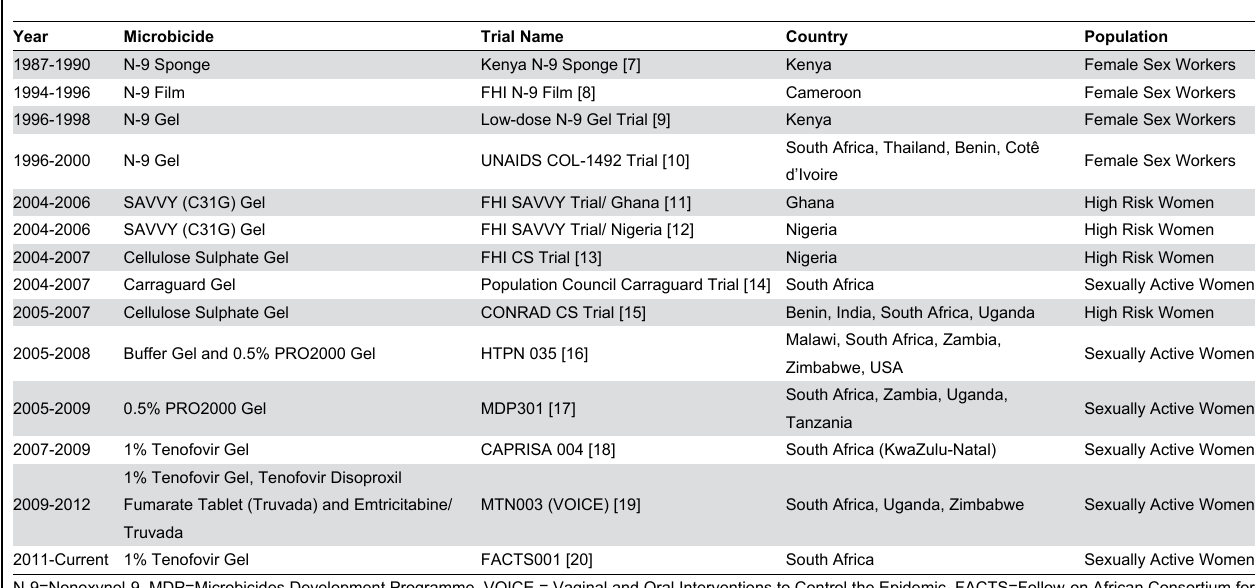
Table 1. Timeline of Microbicide